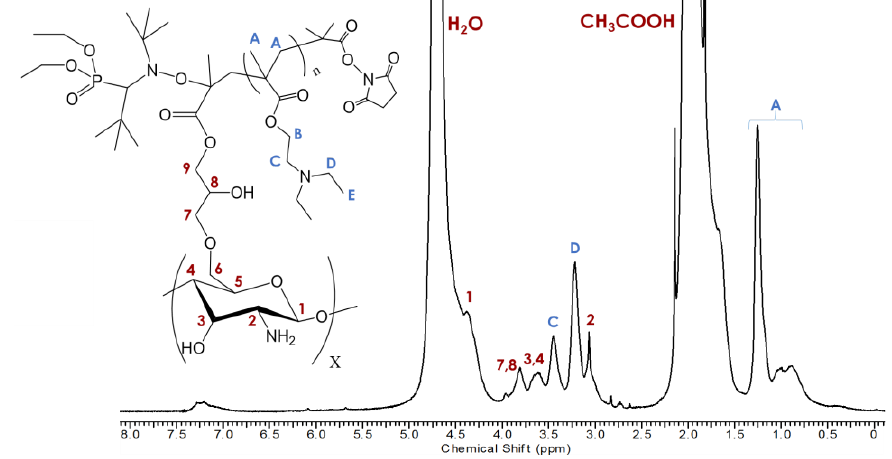
Figure 3. 1 H NMR collected in 0.4 M CH 3 COOH/D 2 O at 5 mg/mL of CTS– g –GMA–PDEAEMA with peak assignments.